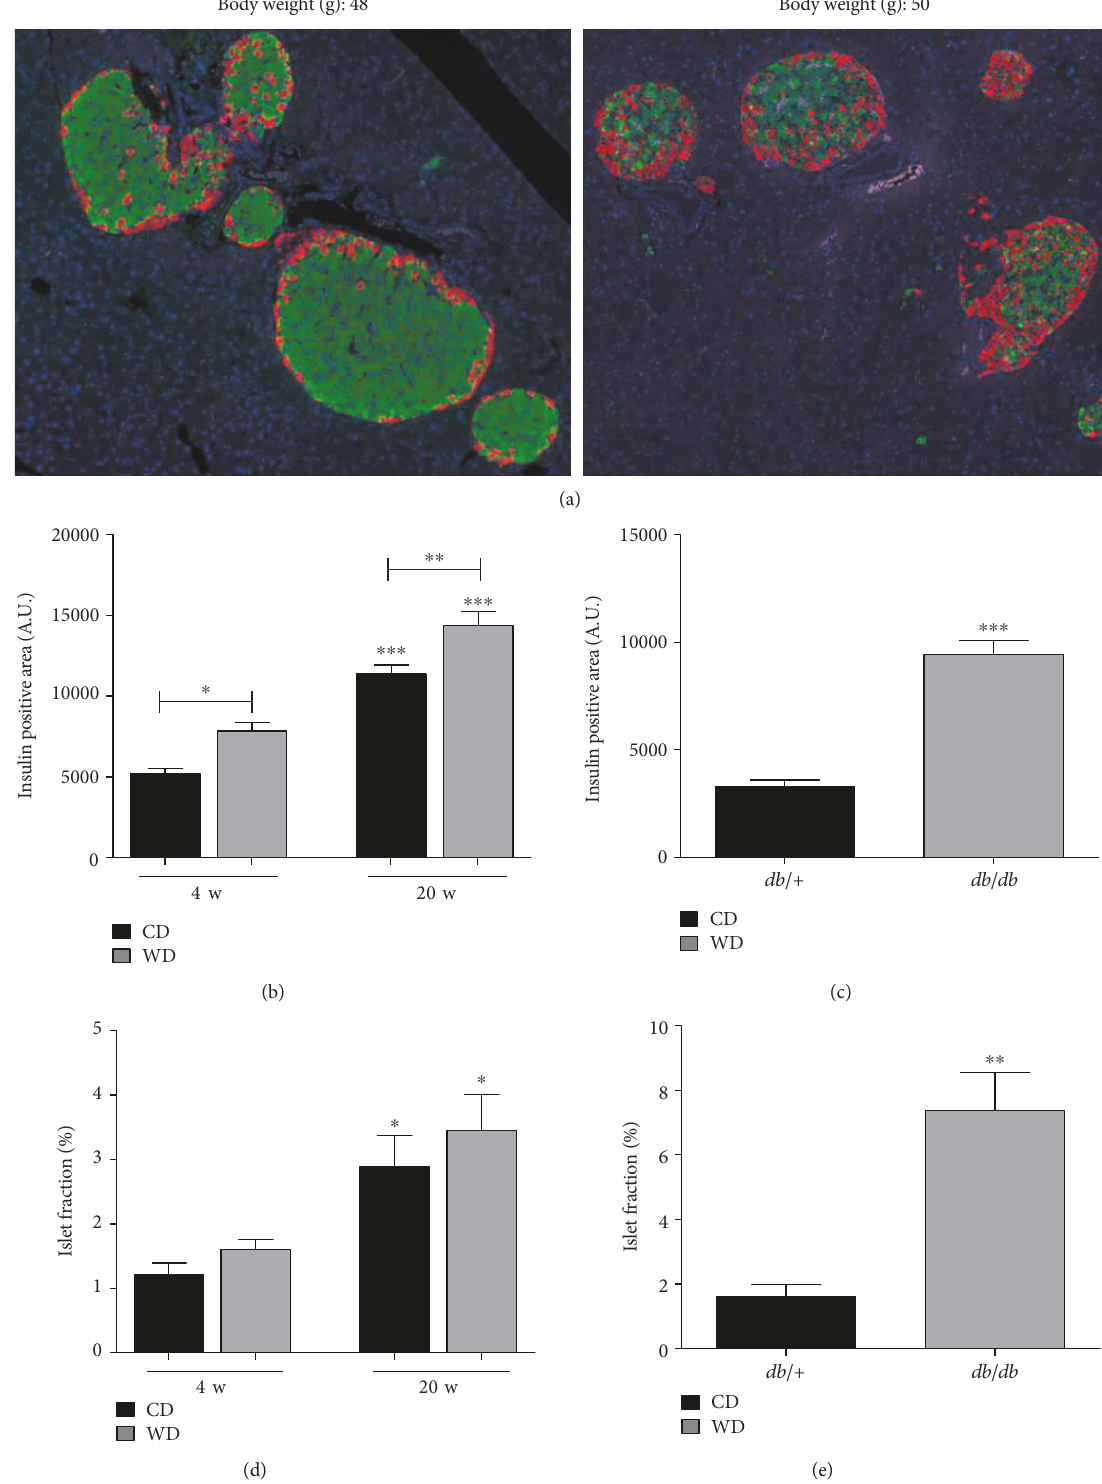
Figure 9: Islet size and insulin-positive area increase in both db/db and WD-fed mice. (a) Immuno fl uorescent images from pancreatic sections stained for insulin (green), glucagon (red), and DAPI nuclear stain (blue) from C57BL/6J fed WD for 20 weeks (left panel) or 14- week-old db/db mice (right panel). Insulin-positive area (b and c) and calculations of islet area relative to total pancreatic area, that is, islet fraction (d and e) are shown for C57BL/6J mice fed either control or Western diet for 4 or 20 weeks (b, d) and 14-week-old db /+ compared with db/db mice (c, e). Insulin-positive area and islet fraction were quanti fi ed using 8 mice per group. Data are shown as mean ± S.E.M. ∗∗∗ p < 0 001 ; ∗∗ p < 0 01 ; ∗ p < 0 05 . CD: control diet; WD: Western